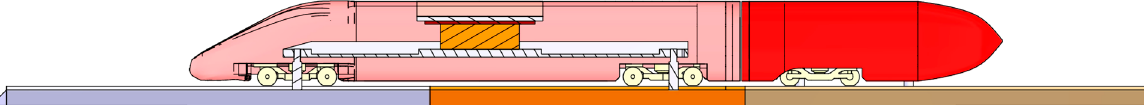
Figure 3. Internal setup for the connection of the dynamometric balance to the train scaled model.